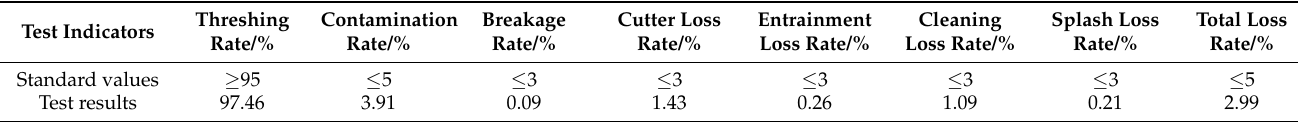
Table 5. Verify test